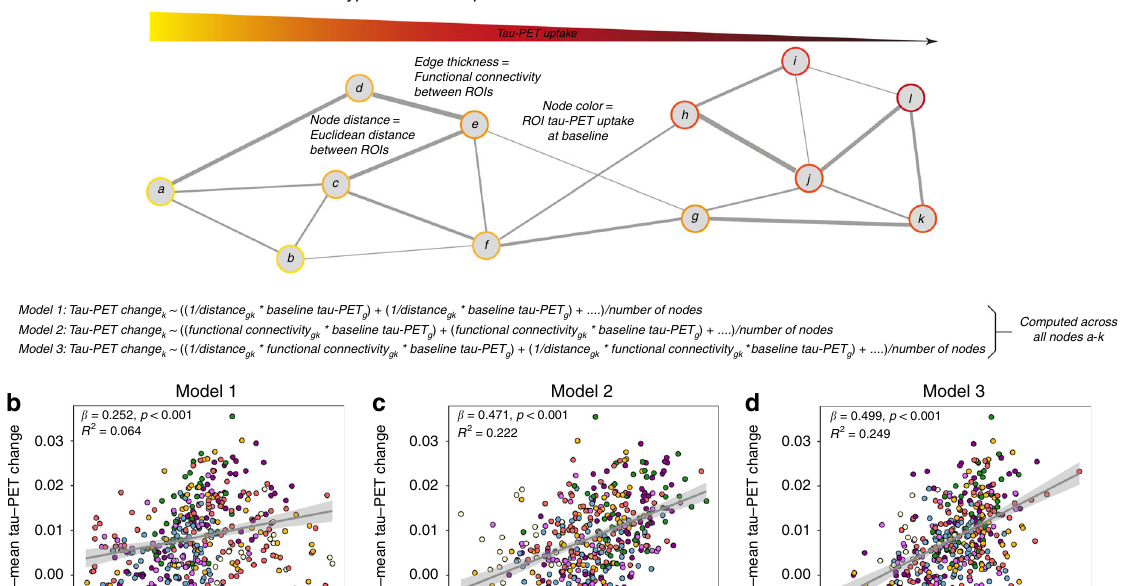
Model2: Model3: Tau-weighted Tau- and distance- functional weighted functional connectivity connectivity